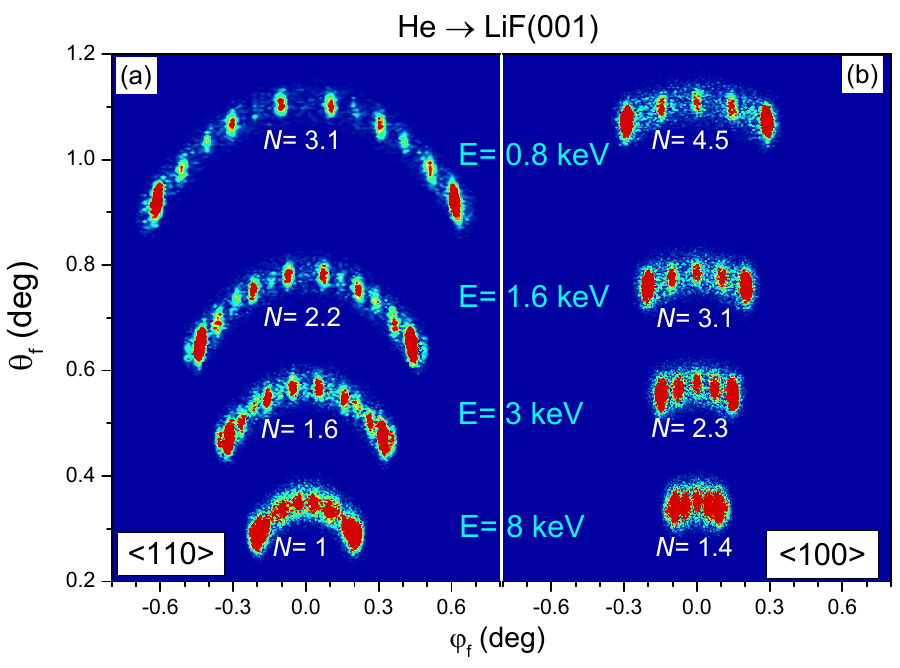
Figure 2. (Color online) Two-dimensional projectile distributions, as a function of θ f and ϕ f , for He atoms impinging on LiF(001) along the ( a ) (cid:104) 110 (cid:105) and ( b ) (cid:104) 100 (cid:105) directions, with E ⊥ = 0.3 eV. The helium beam is collimated by means of a square aperture with d = 0.2 mm. In both panels, angular distributions for different impact energies - E = 0.8, 1.6, 3, and 8 keV - are shown, indicating the corresponding N values, as given by Equation